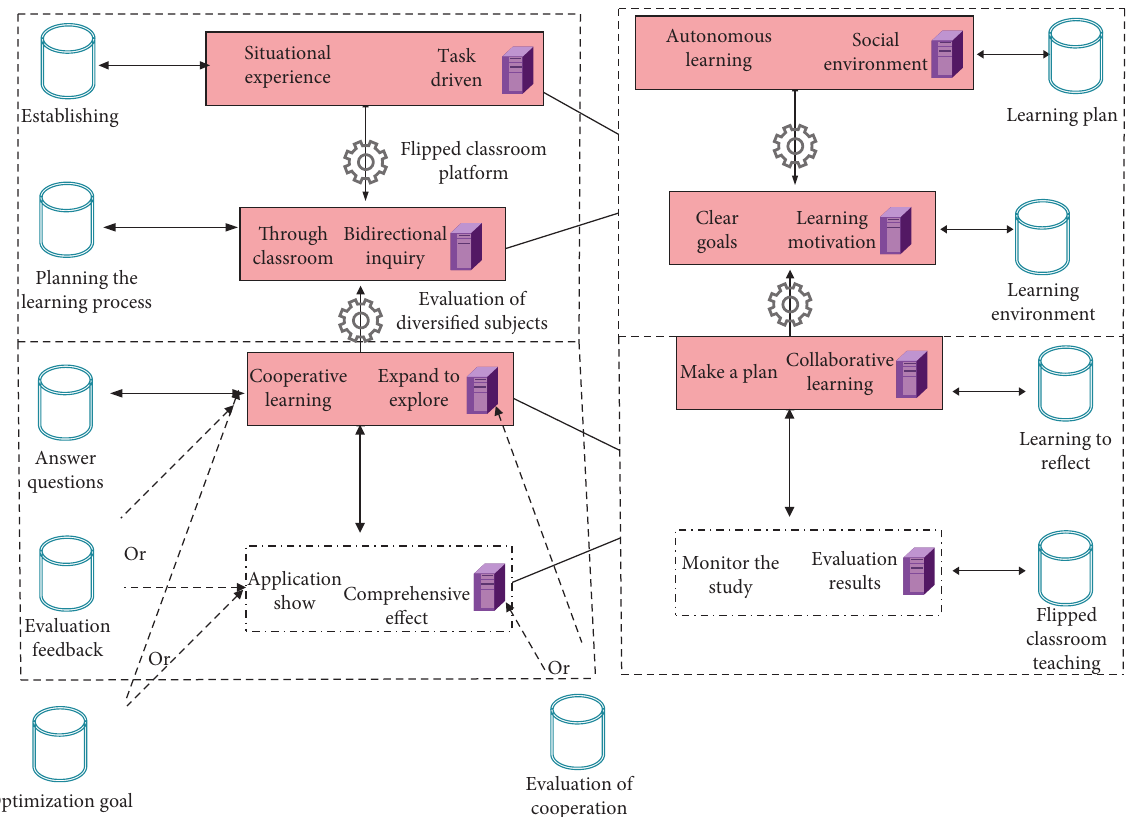
Figure 3: Initial strategy diagram of improving students’ autonomous learning ability in flipped